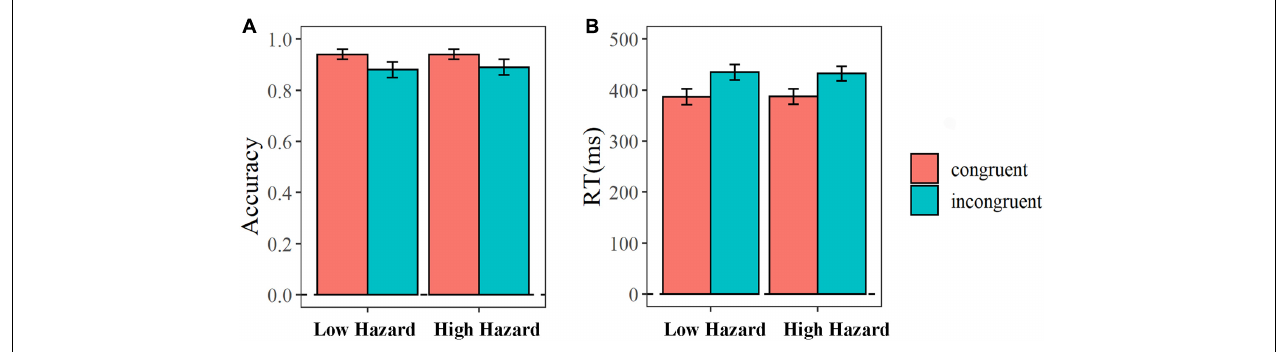
FIGURE 2 | The average accuracy rate (A) and response time (B) in the flanker task. The error bar means the standard error of the mean.